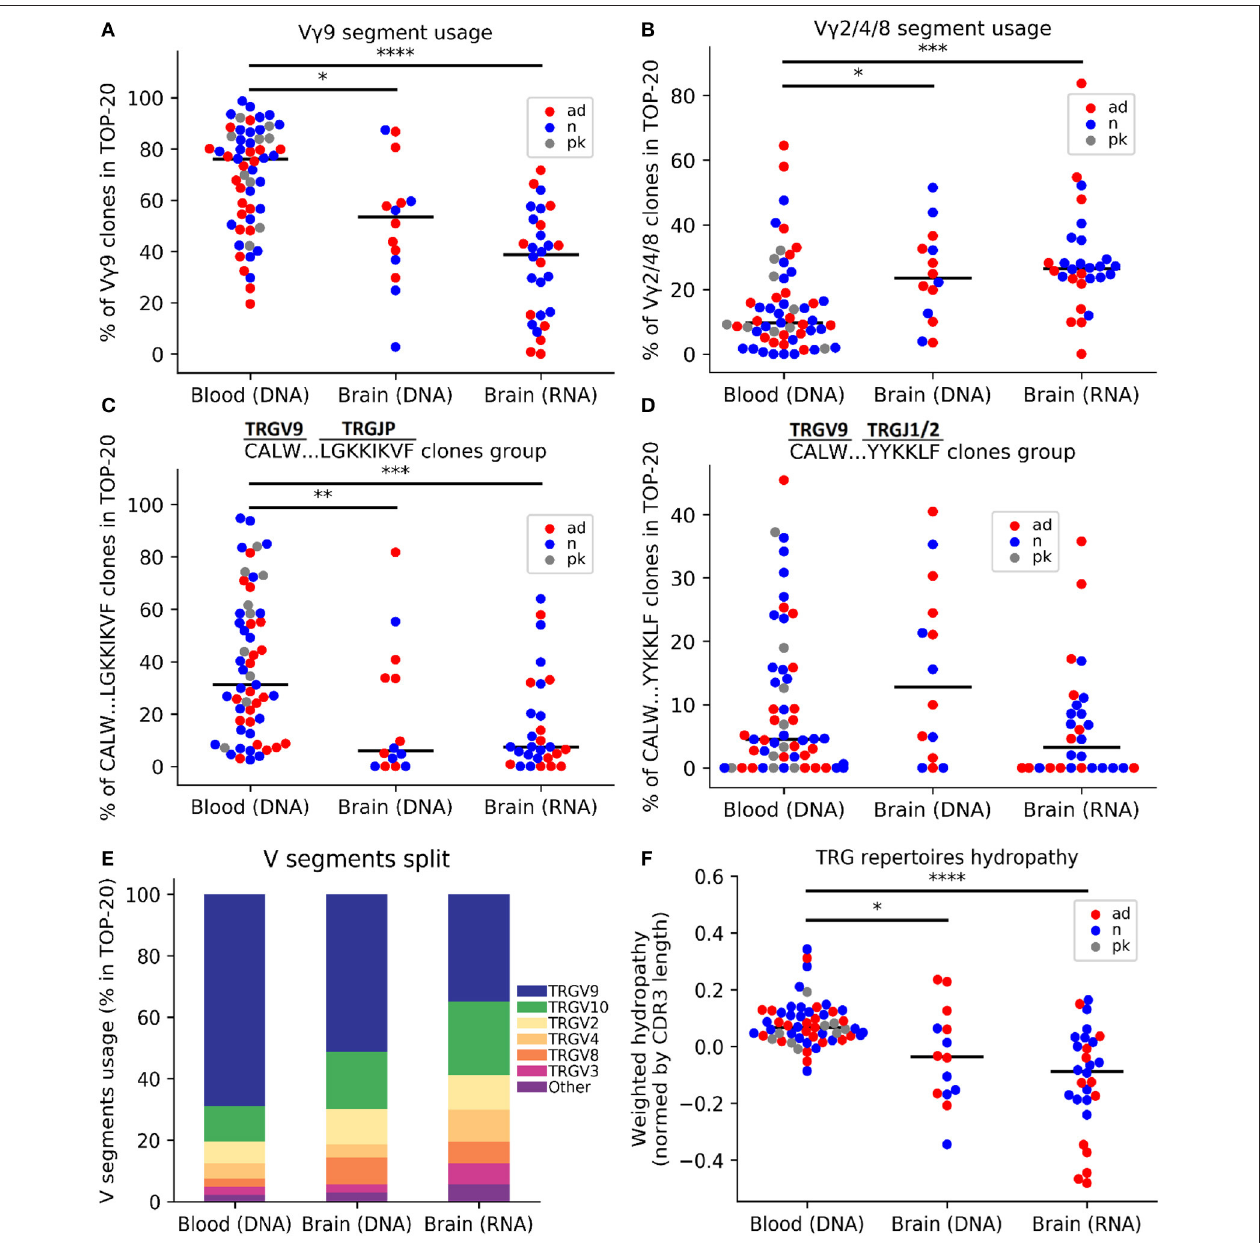
FIGURE 1 | Comparative analysis of the TRG repertoire in the cerebral cortex and peripheral blood. The top 20 TRG repertoire the cerebral cortex differed in V-segment composition from that of the peripheral blood: the TRGV9 segment was predominant in the blood (A) , whereas the proportions of the TRGV2/4/8 segments significantly increased in the brain (B) . The TRGV9-TRGJP clone type “CALW…LGKKIKVF” (where dots indicate any set of amino acids) was significantly more frequent in the blood (C) , whereas other TRGV9 clones did not differ (D) . A schematic of the V-segment distributions of clones in different data groups is presented in (E) . The weighted average repertoire was more hydrophilic in the brain (F) . The colors denote various data groups: red, AD samples; blue, control samples; gray, patients with Parkinson’s disease. Data were analyzed by Kruskal-Wallis ANOVA with Dunn’s post-test comparisons, * P < 0.05, ** P < 0.01, *** P < 0.001, and **** P <